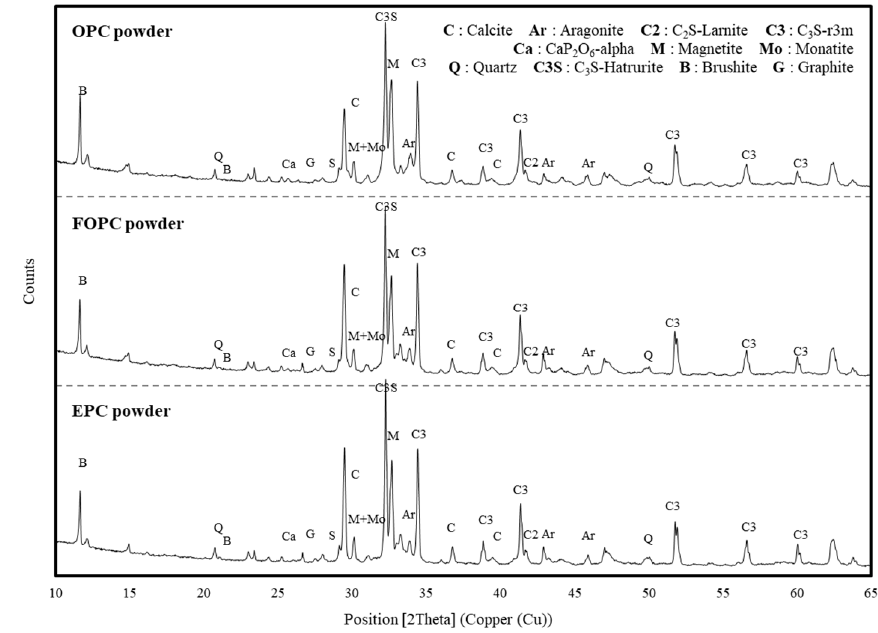
Figure 5. X-ray diffraction patterns obtained for OPC, FOPC, and EPC. Figure 5. X-ray di ff raction patterns obtained for OPC, FOPC, and